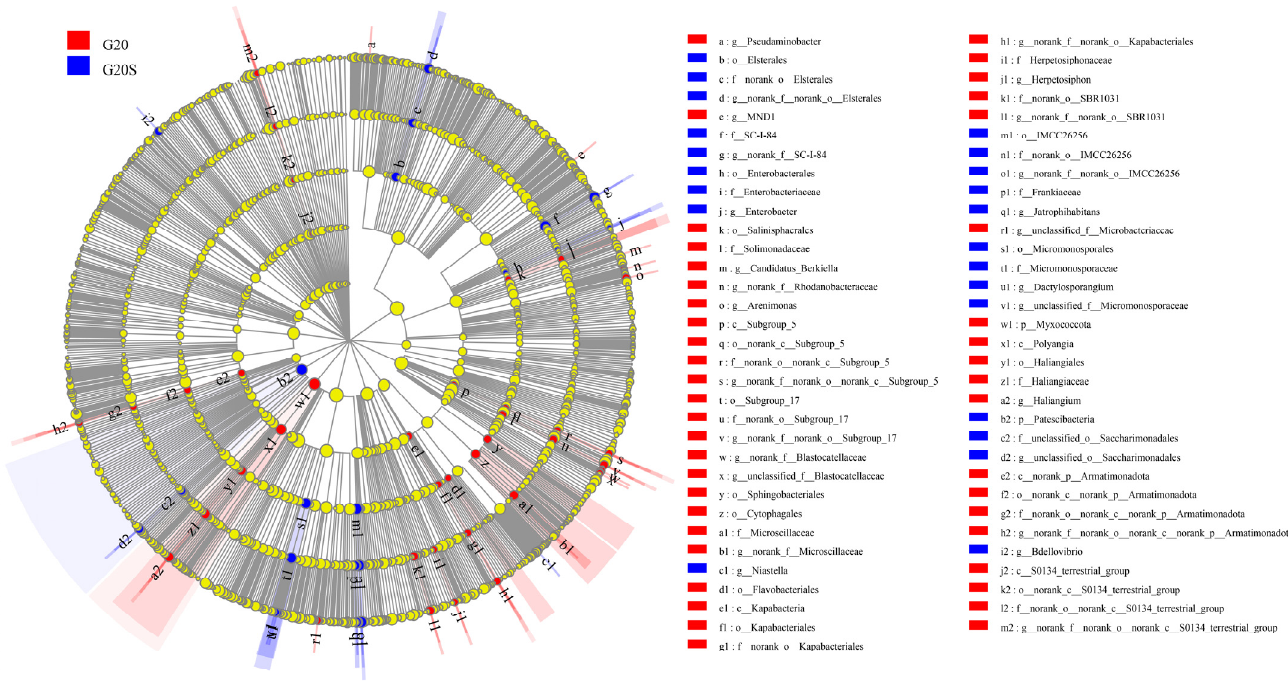
Figure 4. Differential bacterial distribution of the G20 (noninoculation) and G20S (strain SR-9 inoc- ulation)